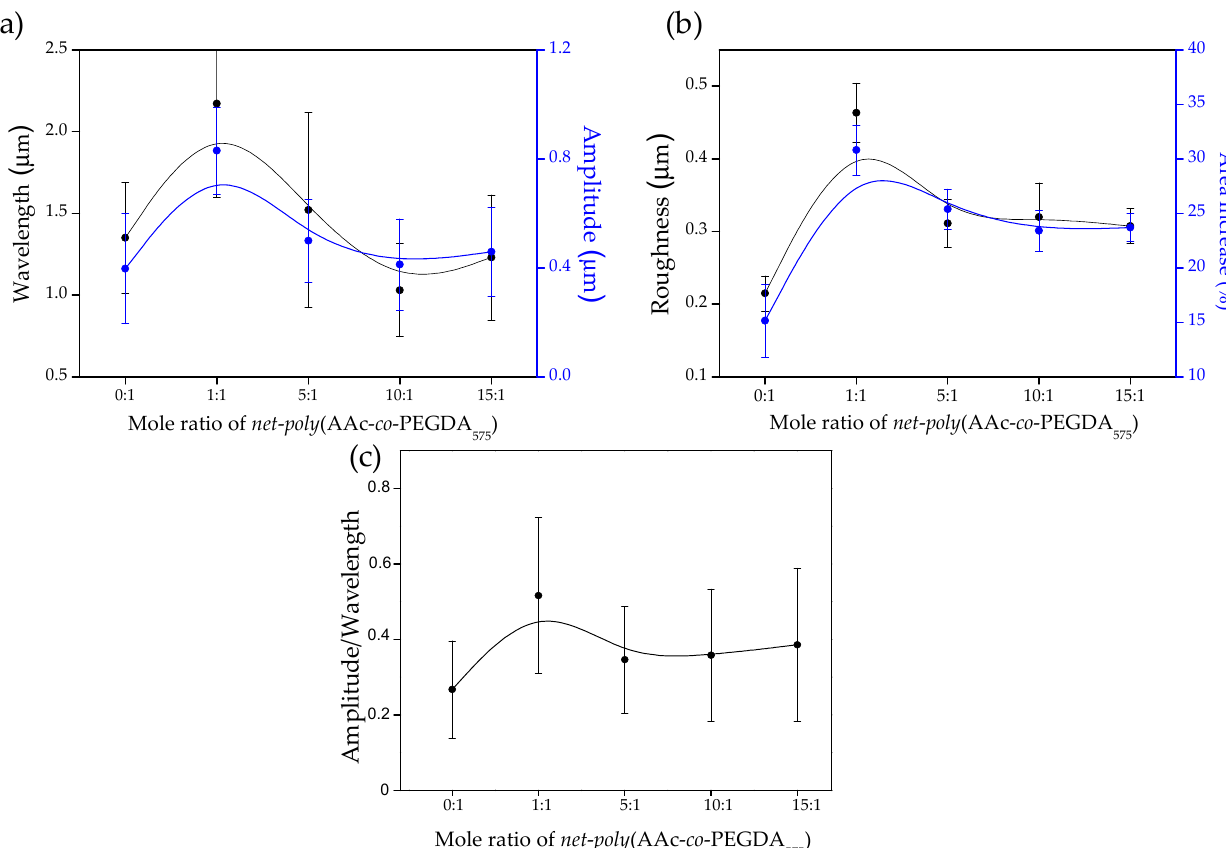
Figure 5. Morphological characteristics obtained from AFM analysis. ( a ) Wrinkle wavelength and amplitude, ( b ) roughness and area increase, and ( c ) aspect ratio of the hydrogel films of net-poly (AAc- co -PEGDA 575 ) at a different mole ratio (0:1, 1:1, 5:1, 10:1, and 15:1).